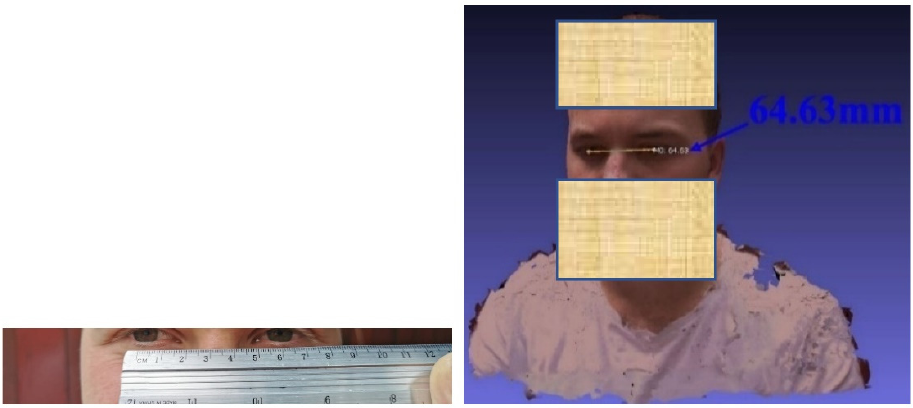
Figure 12. Measuring the client’s pupillary distance.